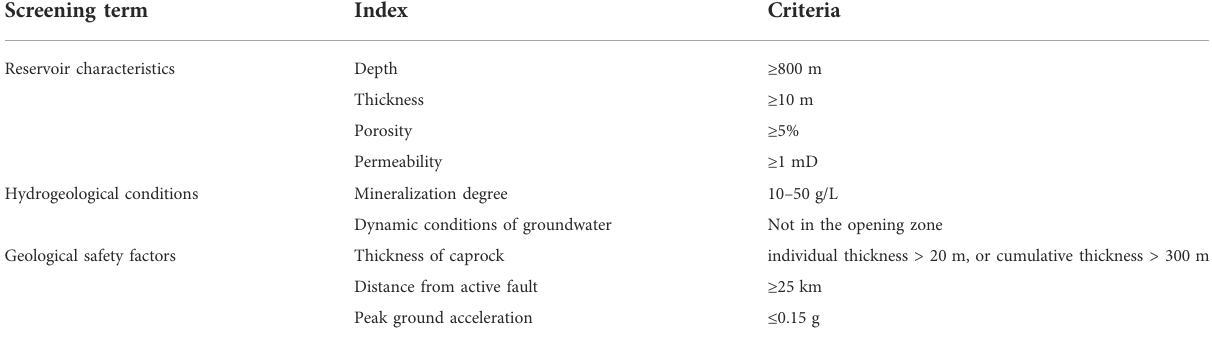
TABLE 2 Reservoir screening